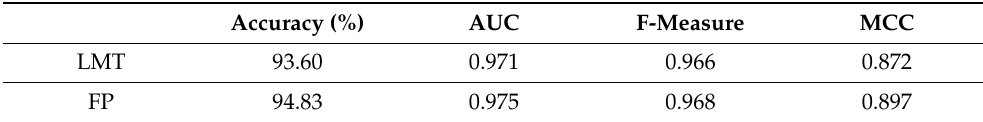
Table 9. The CCP performance of DF models and their Enhanced ensemble variants on balanced Dataset